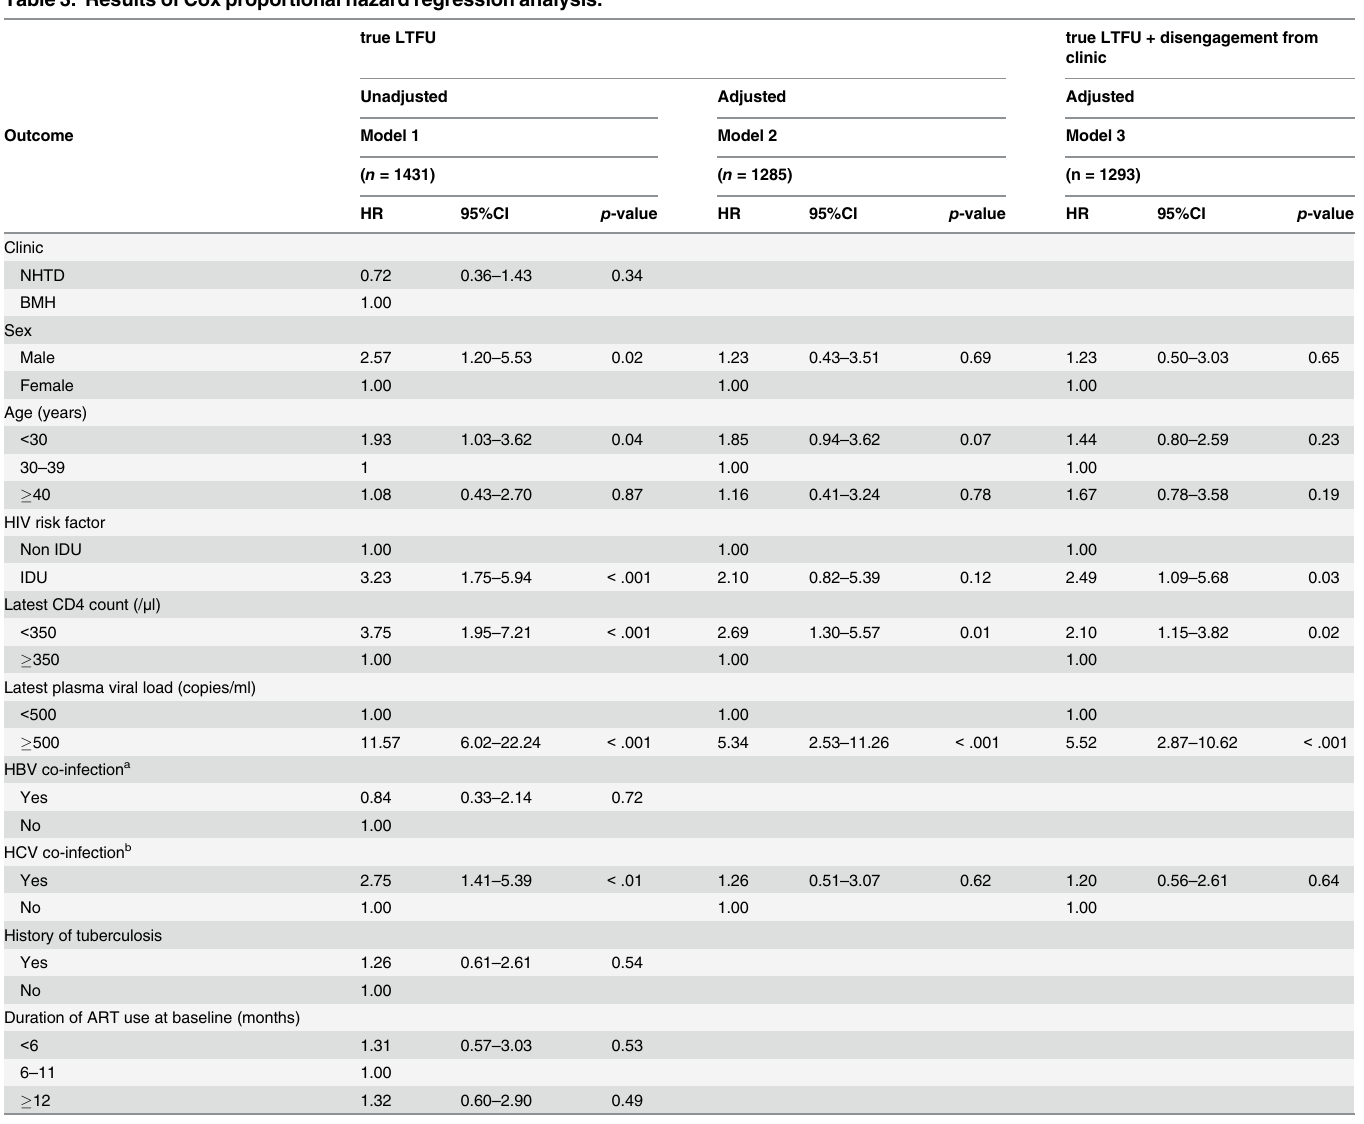
Table 3. Results of Cox proportional hazard regression